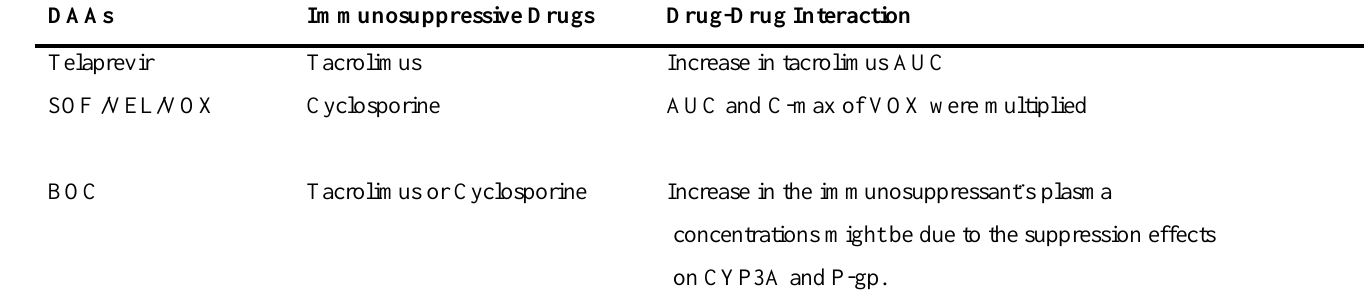
Table 4. Drug-Drug interactions between DAAs and Immunosuppressive Drugs